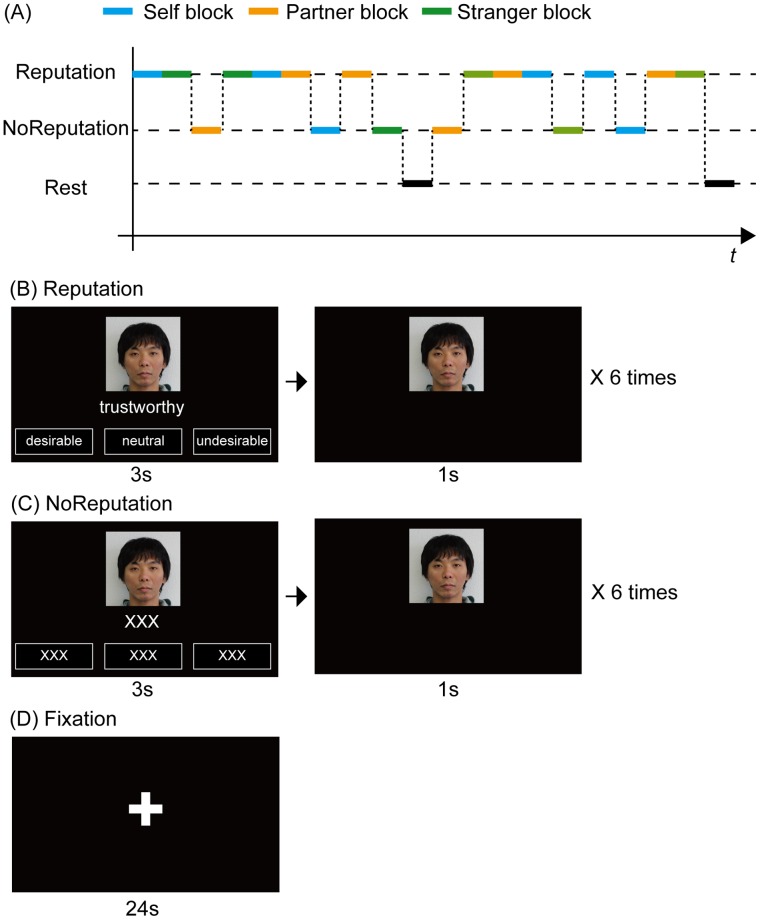
Experimental flow.(A) An example condition sequence is shown. The reputation and no-reputation conditions for three targets (self, partner, and stranger) were presented in a pseudorandom order. (B) Visual stimuli in the reputation condition are shown. A photograph of the evaluation target was presented throughout the reputation condition. The adjectives evaluated by ostensible evaluators and three choices in terms of desirability rating were presented for 3 s in the lower part of the display. Subjects were required to rate the social desirability of the adjectives irrespective of the evaluation target for 3 s. Three seconds after the adjective onset, the adjective and choices disappeared, and the photograph of the evaluation target alone was displayed for 1 s. In the reputation-condition block, six adjectives were displayed sequentially. (C) Visual stimuli in the no-reputation condition are shown. Here, ‘XXX’ was displayed instead of the adjectives and choices in the reputation condition. (D) In the rest-condition block, a fixation cross was presented at the center of the screen for 24 s.